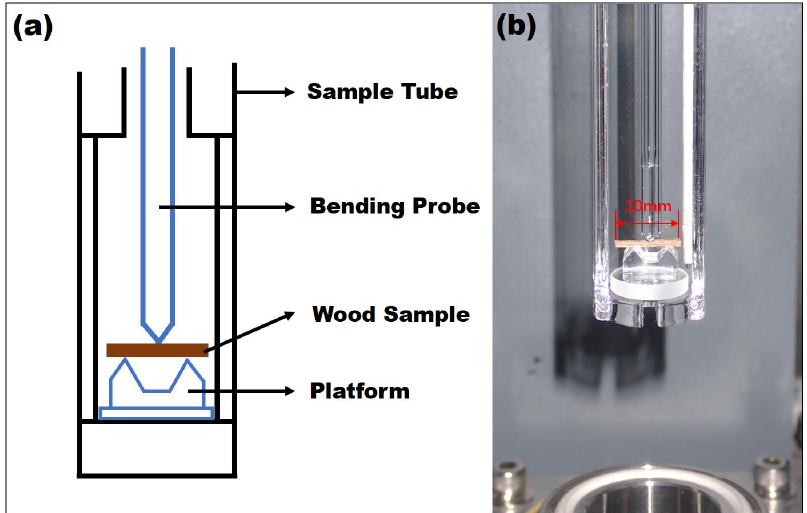
Figure 2. Mechanical properties of archaeological wood tested with TMA: ( a ) schematic diagram of bending test components; ( b ) image of bending test.